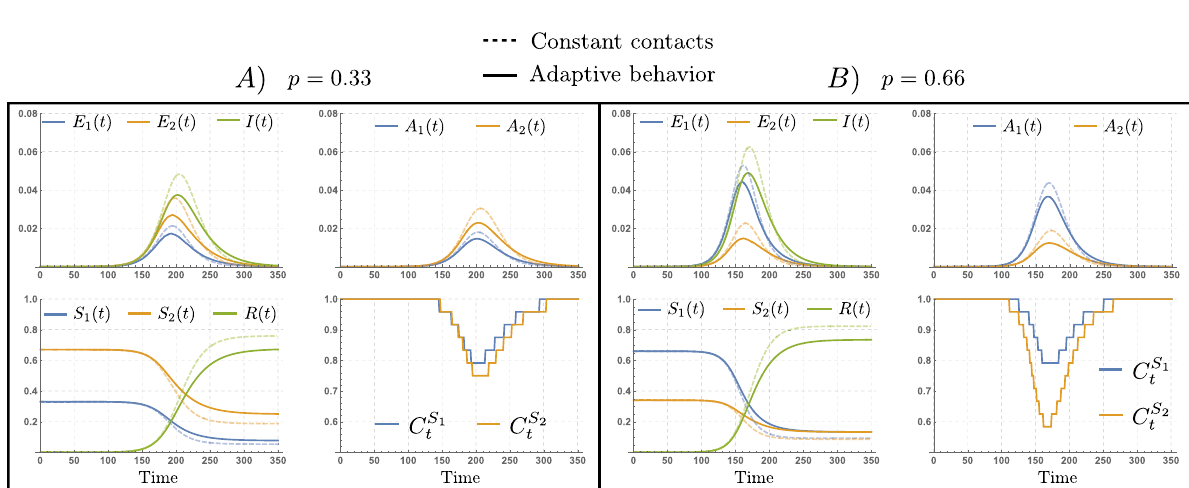
Figure 3. Variations in the proportion of RT individuals impact disease dynamics and behavioral responses. Disease dynamics under constant contacts model (dashed curves) and under adaptive behavior model (thick curves). The scenarios where 33% ( A ) and 66% ( B ) of the population are high-risk takers show distinct disease dynamics, inducing differential behavioral responses ( C S 1 t and C S 2 t ) as a function of the risk perception. The set of parameters used are those in Table